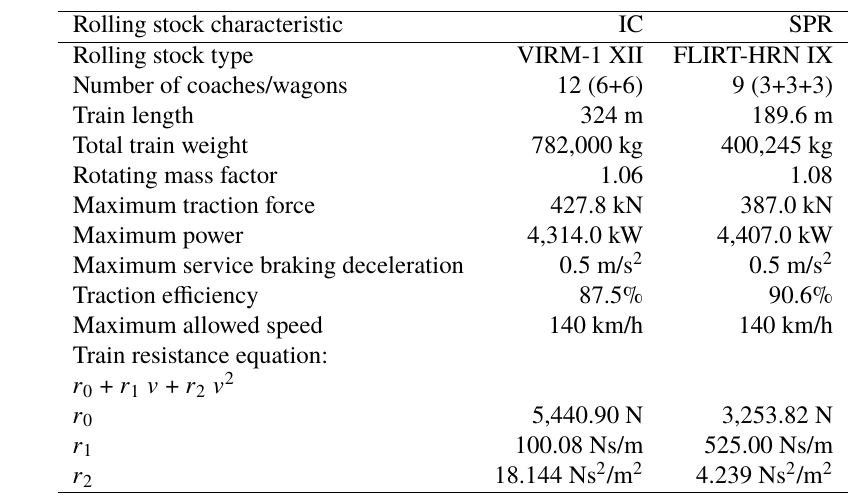
Table 8: Timetable characteristics and blocking time